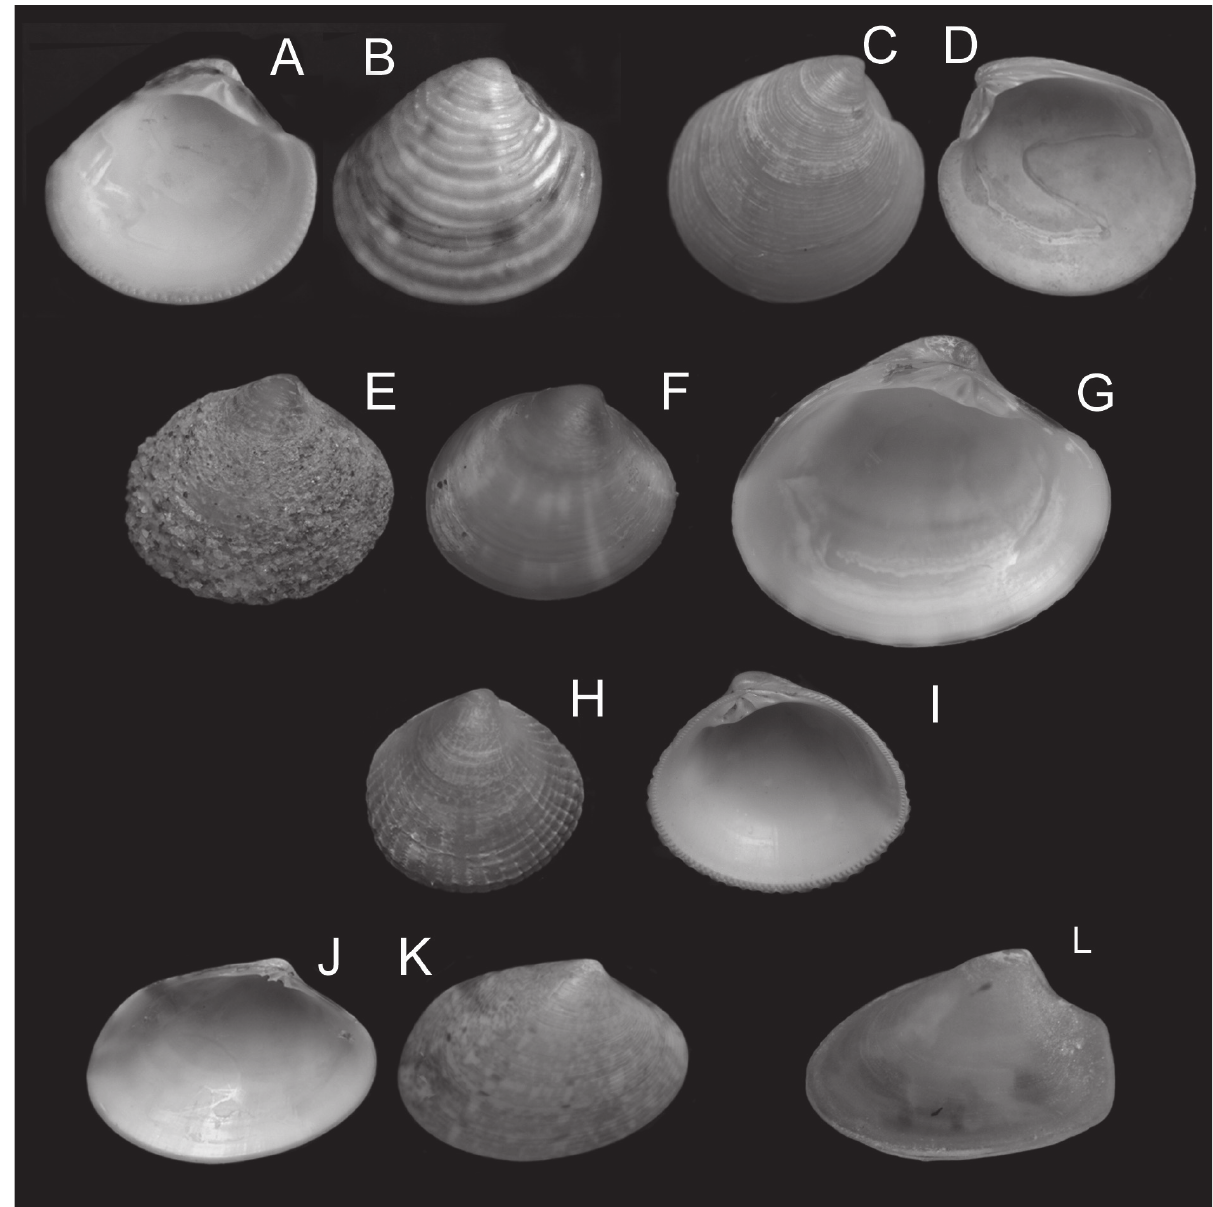
Fig . 7. – infaunal bivalves of Zostera marina . a, B, inside view of left valve and outside view of right valve of C. gallina (shell length: 7.1 mm); C, d, outside and inside view of right valve of D. lupinus (4 mm); e, outside view of right valve of juvenile Pitar rudis (3.5 mm) showing the characteristic periostracum with sand grains; f, the same specimen without periostracum; g, inside view of left valve of P. rudis (11 mm); H, outside view of right valve of juvenile Timoclea ovata (2 mm); i, inside view of right valve of T. ovata (7.5 mm); J, K, inside view of left valve and outside view of right valve of Venerupis aurea (11.2 mm); L, outside view of left valve of juvenile Thracia villosiuscula (2